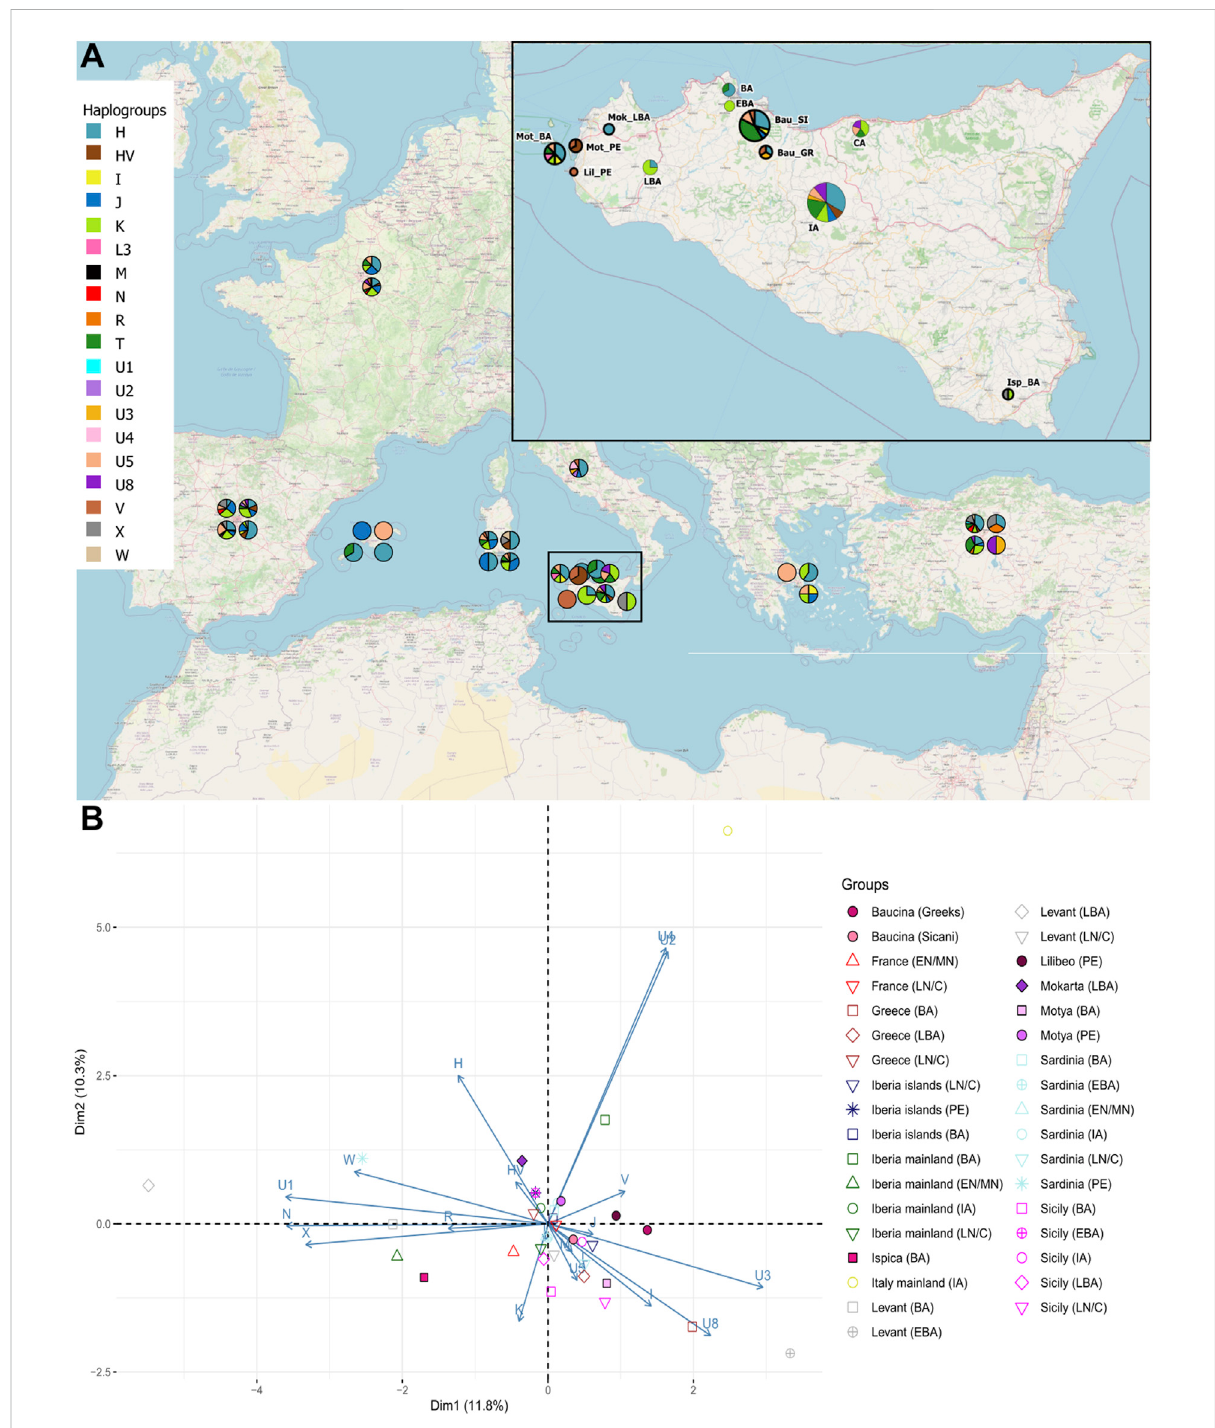
FIGURE 2 Mitochondrial genetic structure of ancient Sicily. (A) Geographical distribution of haplogroup frequency in the analyzed samples. (B) Principal Component Analysis (PCA) onthehaplogroup frequencieswithingroups;geographical populationare indicatedwith differentcolors, while cultures are indicated with different symbols and labelled as follow: EN/MN = Early/Middle Neolithic, LN/C= Late Neolithic/Chalcolithic, BA = Bronze Age, EBA = Early Bronze Age, LBA = Late Bronze Age, IA = Iron Age, PE =